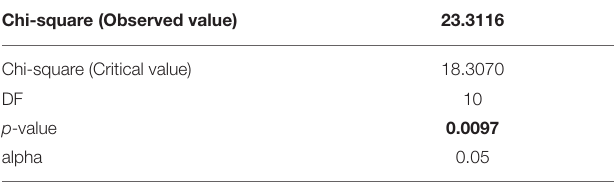
TABLE 1B | Bartlett’s sphericity